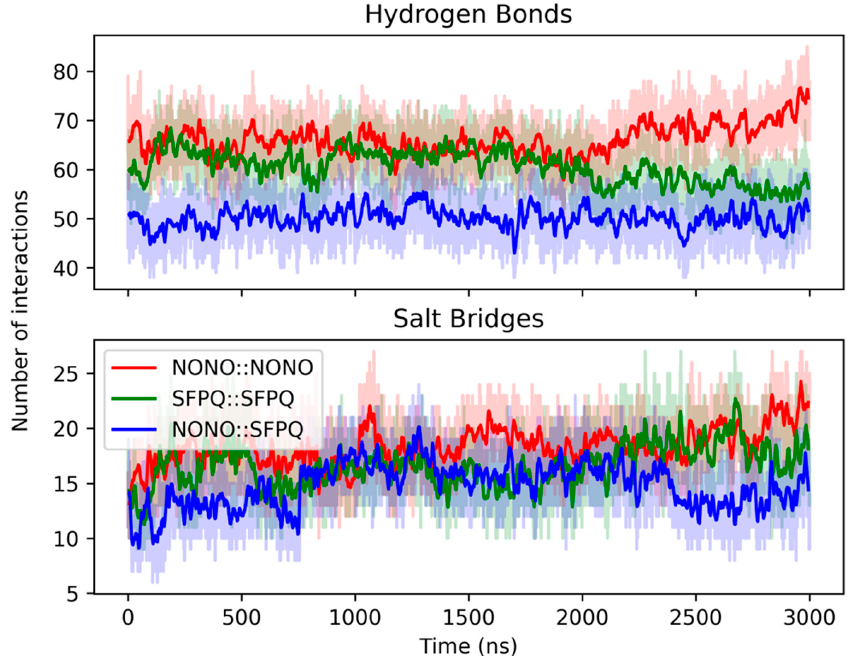
Figure 2. MD polar interactions. NONO::NONO (red), SFPQ::SFPQ (green), NONO::SFPQ (blue). Total number of polar interactions and their fluctuations was stable in all systems. The NONO::SFPQ heterodimer displayed a smaller count of total hydrogen bonds, compared to the other